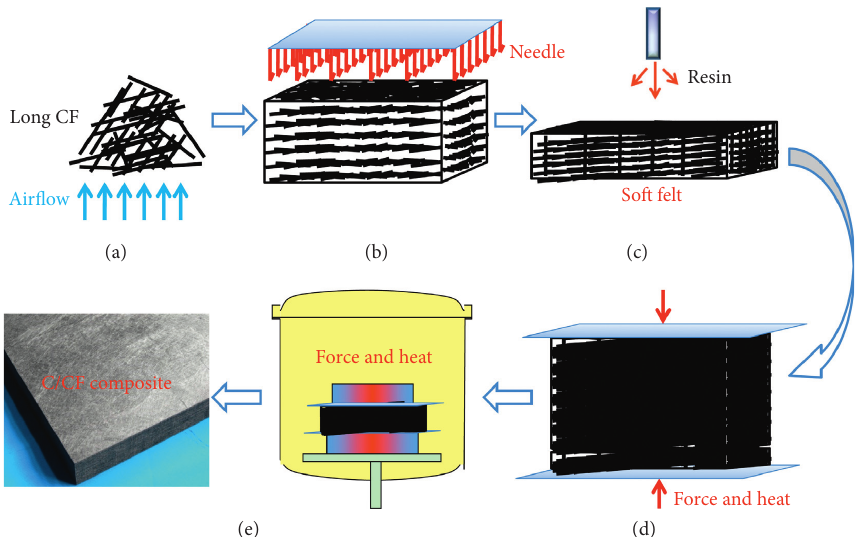
Figure 1: Schematic diagram of the preparation process of the carbon/carbon fiber composite. (a) Airflow netting. (b) Needle punching forming felt. (c) Resin impregnation. (d) Molding curing. (e) Carbonization and graphitization.